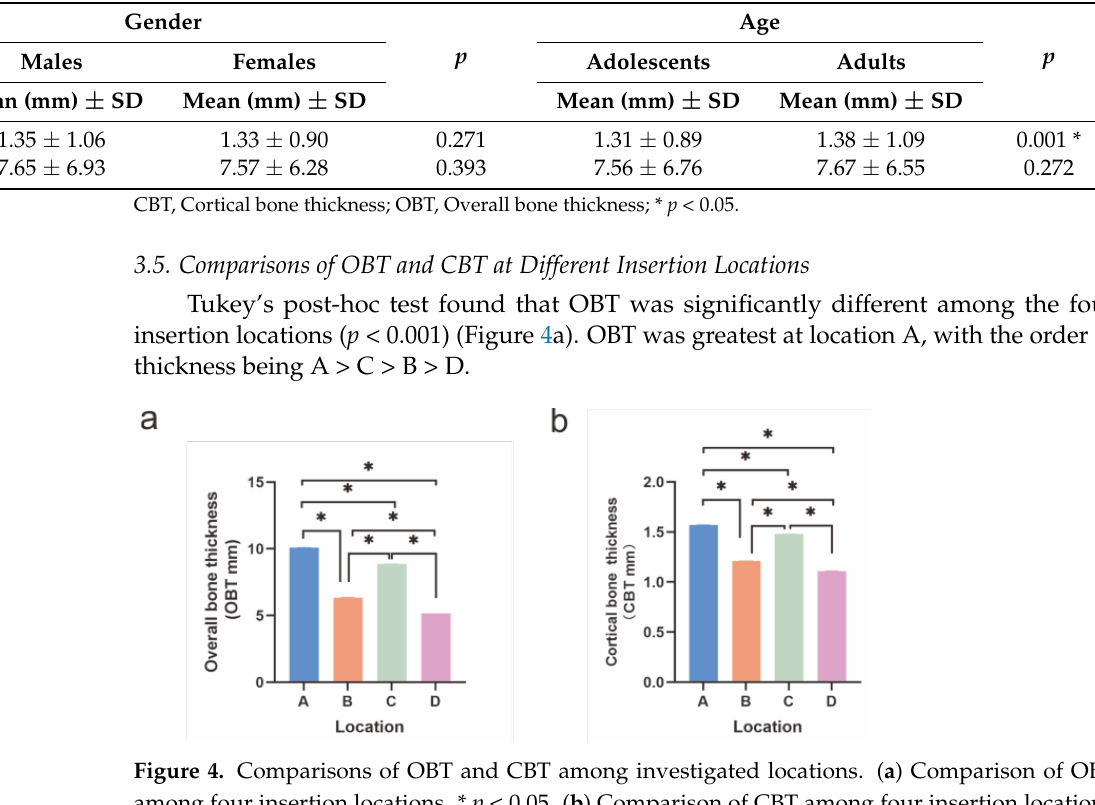
Table 1. Variance analysis of influence of gender and age on cortical bone thickness and overall bone thickness .